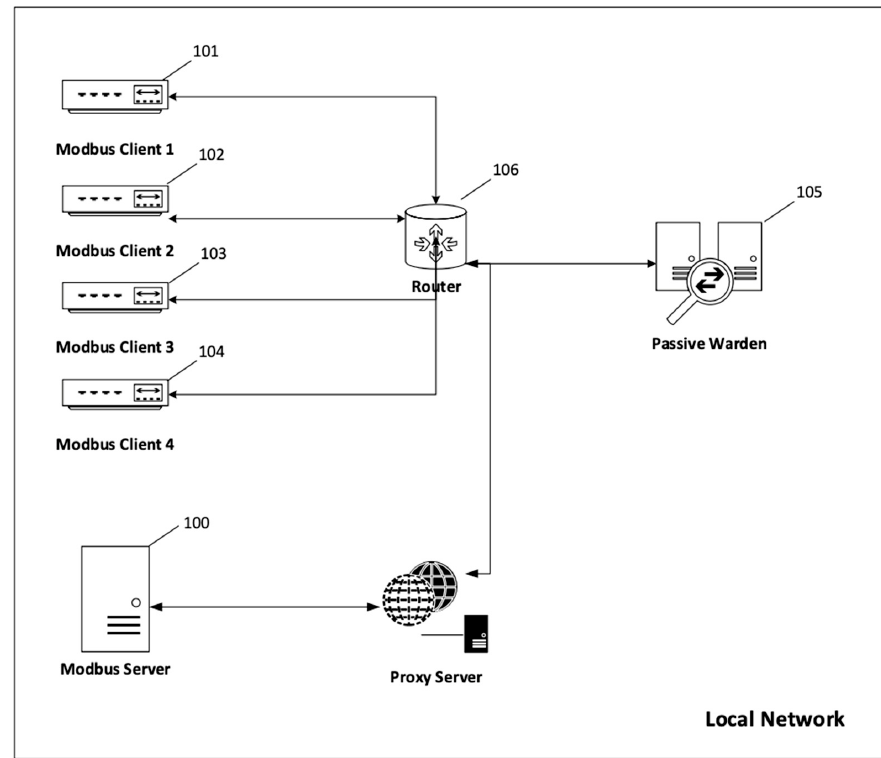
Figure 9. Multi-device architecture extended around the proxy.